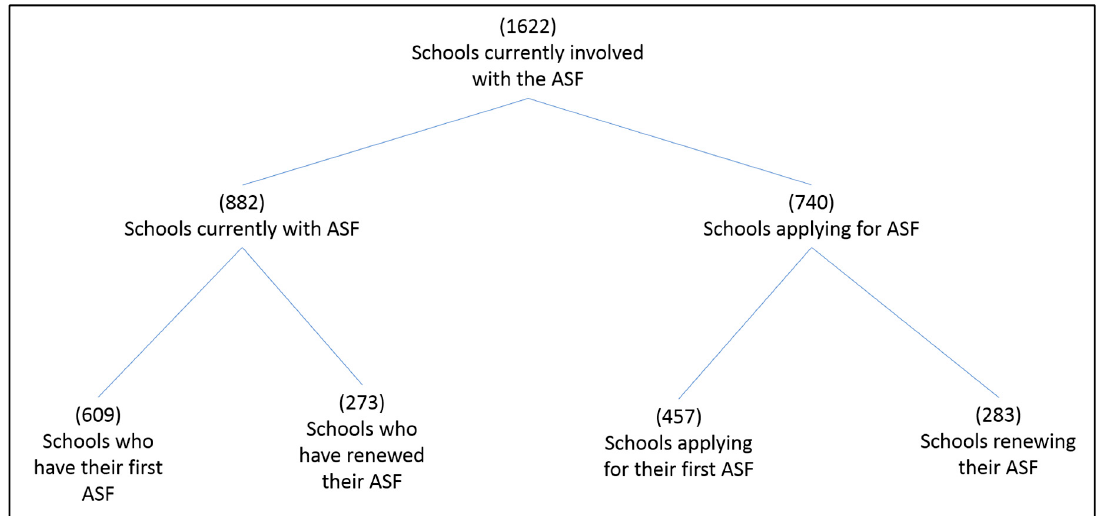
Figure 3. Breakdown of schools currently engaged with the ASF.